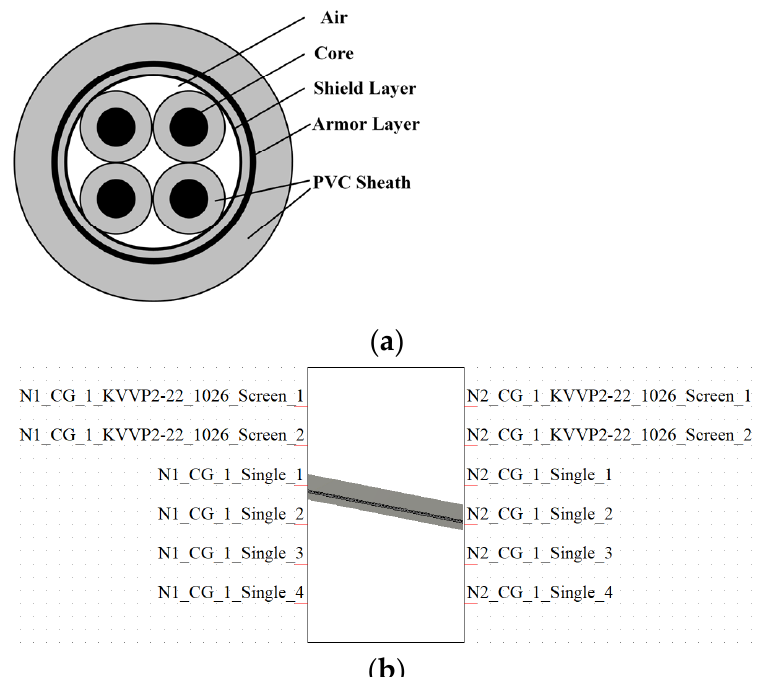
Figure 4. Quad cable simulation model. ( a ) Sectional view of quad cable; ( b ) spice model of quad